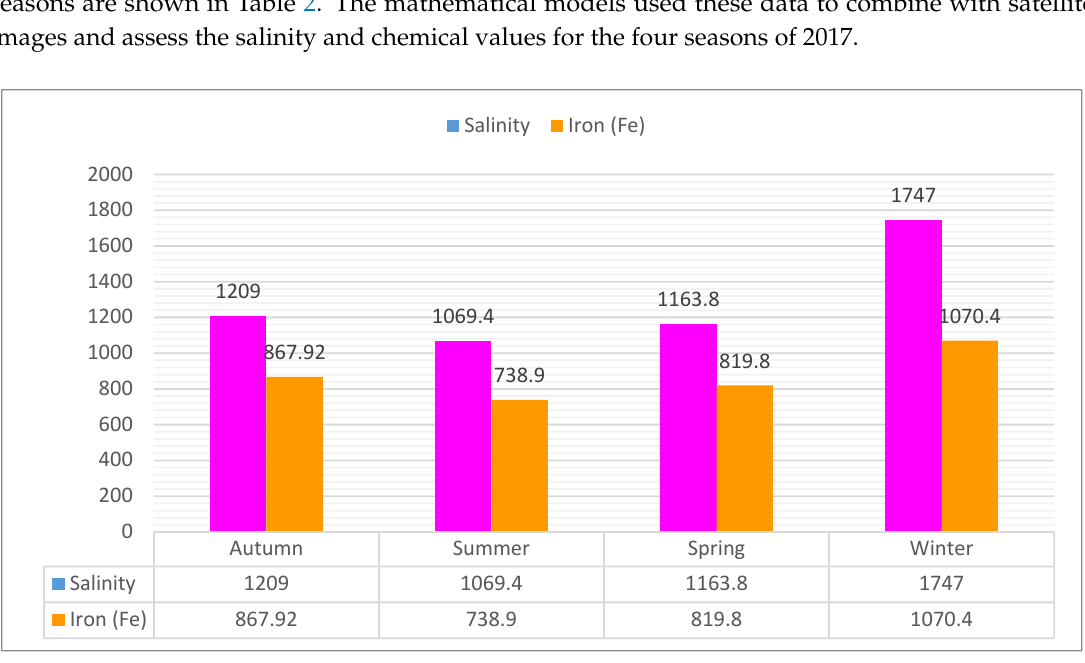
Table 2. Laboratory measurements of salinity and chemicals over four seasons in 2017